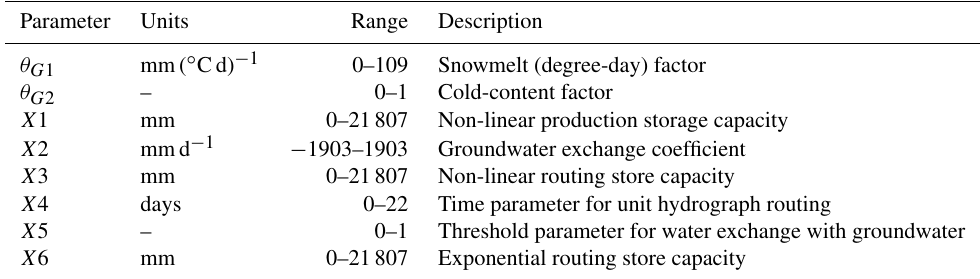
Table 3. CemaNeige–GR6J model parameters and their transformed real value ranges.